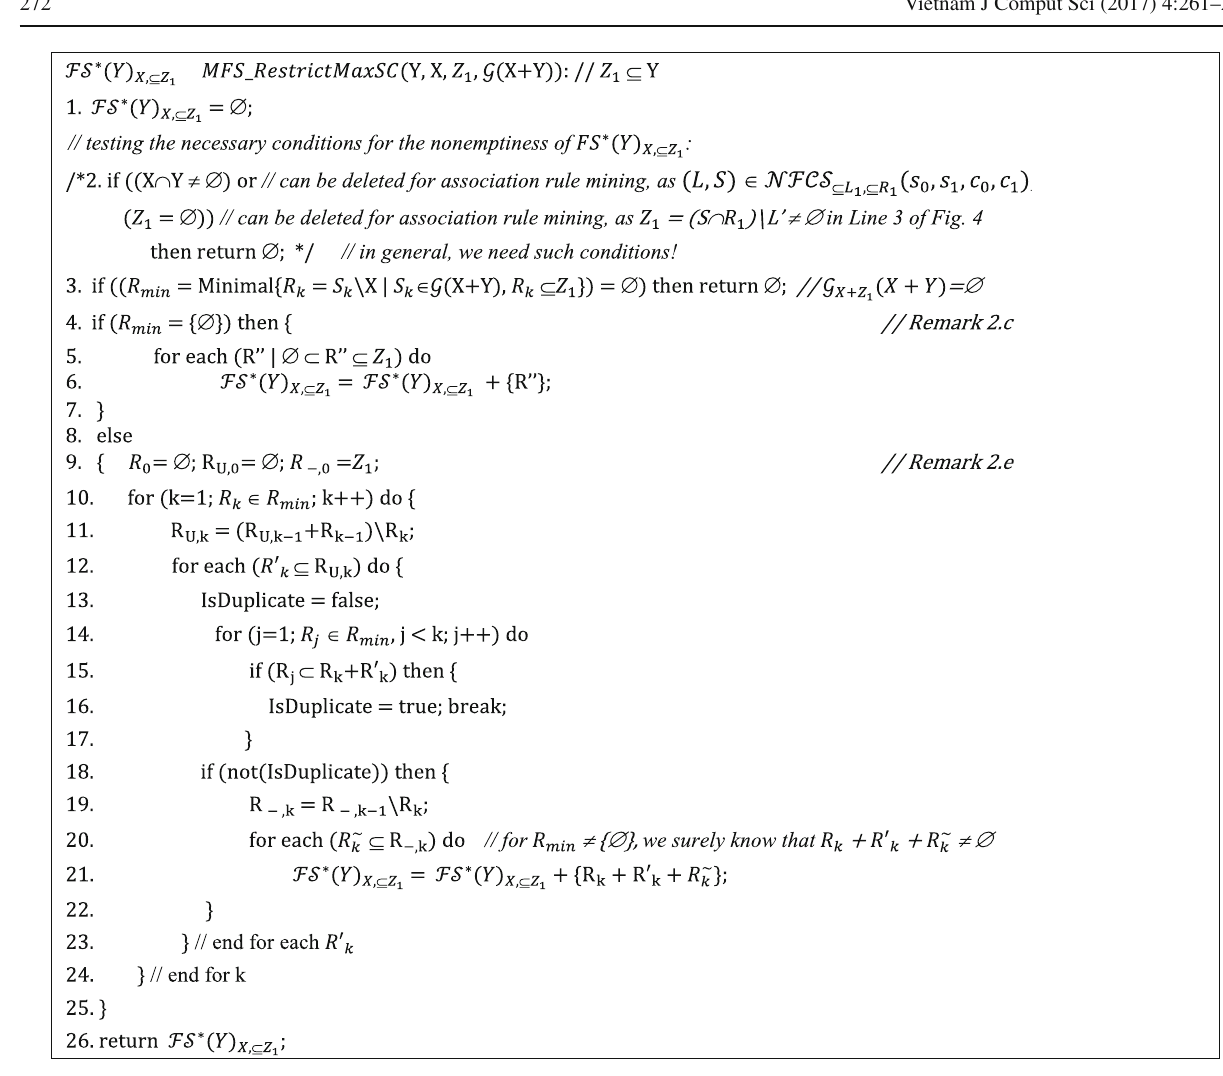
Fig. 3 The MFS _ RestrictMaxSC procedure